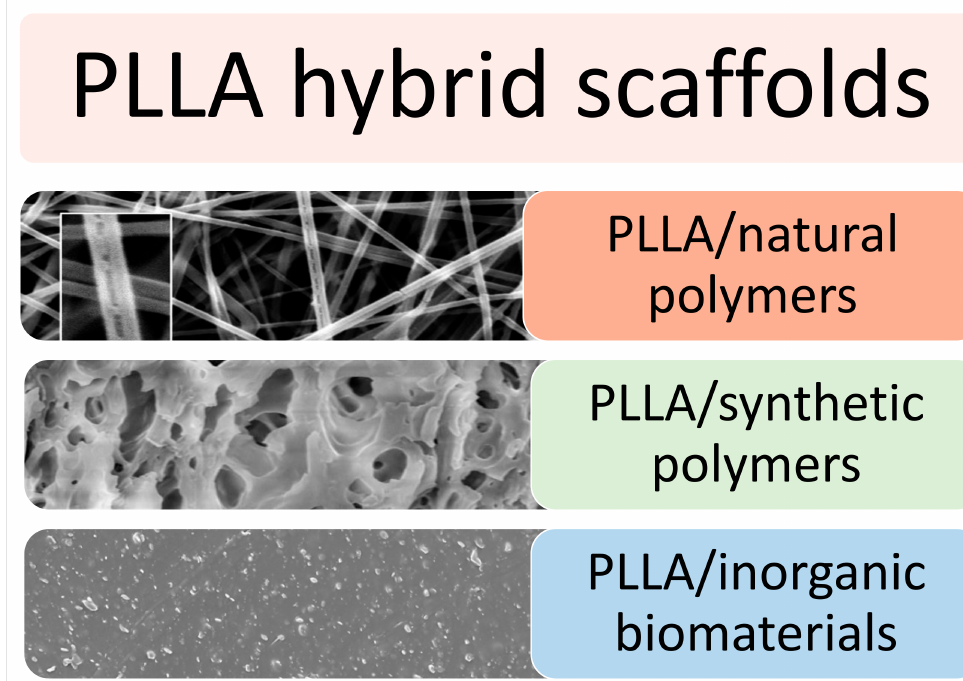
Figure 7. Microstructure of PLLA-based hybrid scaffold in combination with natural polymers, synthetic polymers or inorganic biomaterials. Reprinted with permission from RSC [135] and MDPI